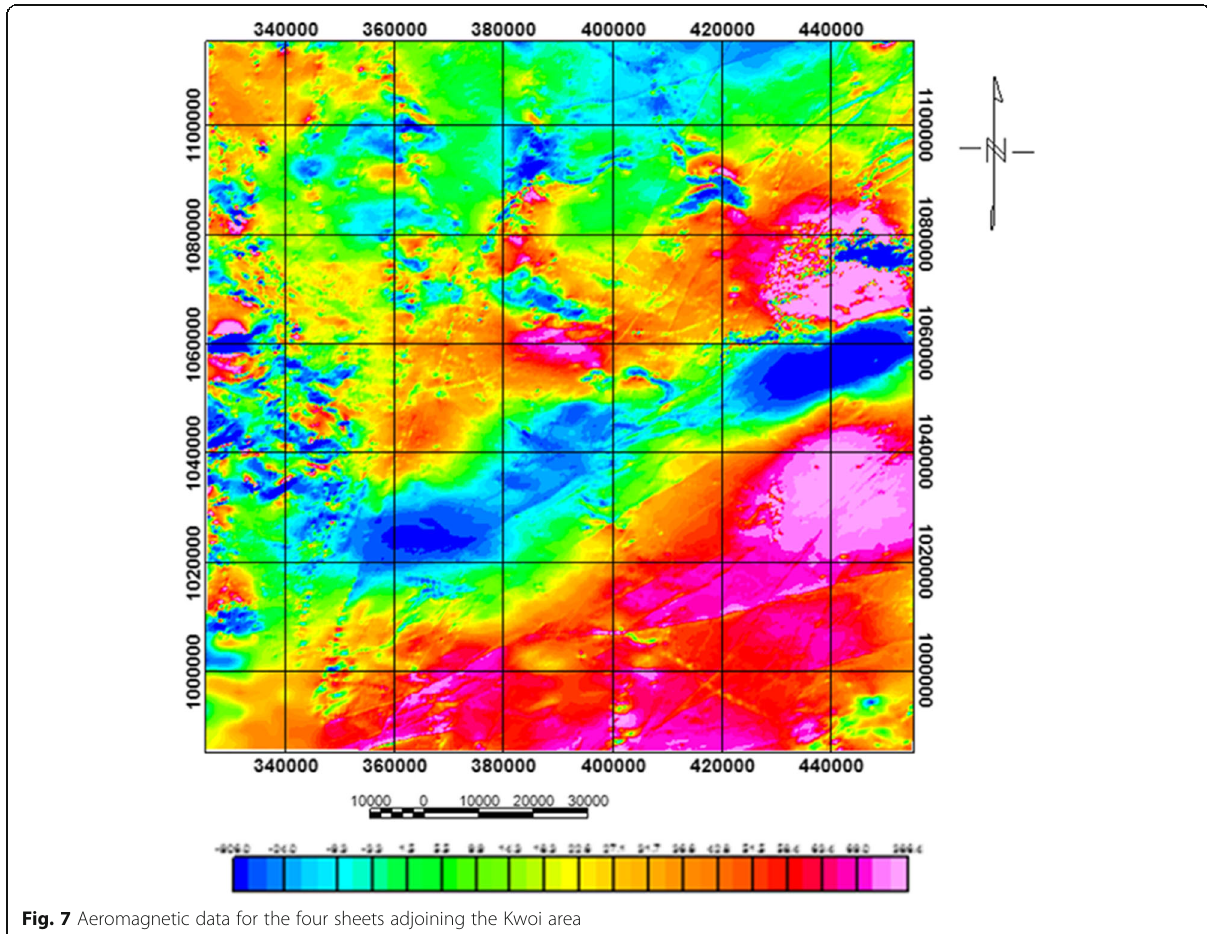
Fig. 7 Aeromagnetic data for the four sheets adjoining the Kwoi area